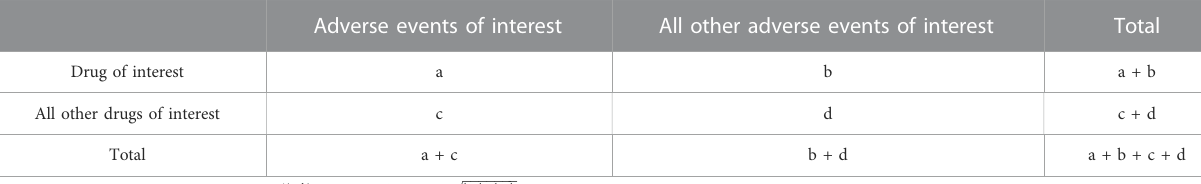
TABLE 1 Two-by-two contingency table for disproportionality analyses. Adverse events of interest Drug of